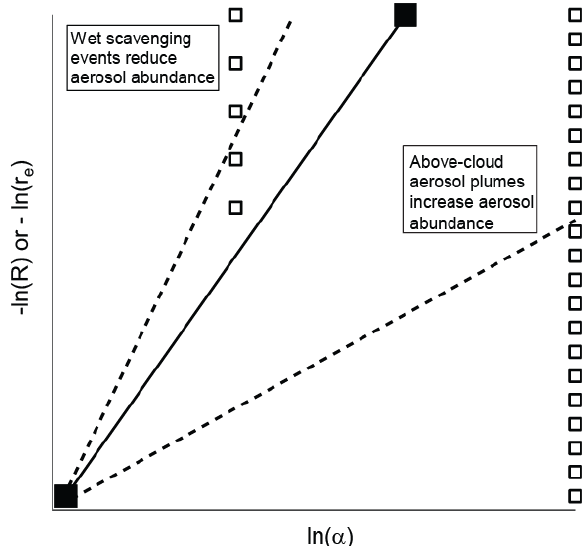
Figure 4. A visual description of the effect that high and low aerosol concentrations could 681 Fig. 4. A visual description of the effect that high and low aerosol potentially have on quantification of ACI and concentrations could potentially have on quantification of ACI and S 0 o when using collocated aerosol-cloud satellite data. The thick data. The thick solid line represents a hypothetical slope when plotting –ln( R ) or –ln( r solid line represents a hypothetical slope when plotting − ln( R) or – ln( a ), which corresponds to ACI and ln( r e ) versus ln( α ), which corresponds to S 0 o and ACI, respectively. With above-cloud aerosol plumes, a cluster of points at high lev- cluster of points at high levels of ln( a ) will reduce the slope (i.e. lower ACI and els of ln ( α ) will reduce the slope (i.e. lower ACI and S 0 o ) . Low aerosol concentrations as a result of wet scavenging likely will have aerosol concentrations as a result of wet scavenging likely will have a greater impact for the most 686 a greater impact for the most polluted scenes where there is a greater polluted scenes where there is a greater potential to have a reduction in aerosol concentration. 687 potential to have a reduction in aerosol concentration. This will lead This will lead to a higher slope (i.e. higher ACI and to a higher slope (i.e. higher ACI and S 0 o ) . The χ metric is rela- tively insensitive to these effects as it avoids the use of retrieved these effects as it avoids the use of retrieved aerosol data. 689 aerosol 690